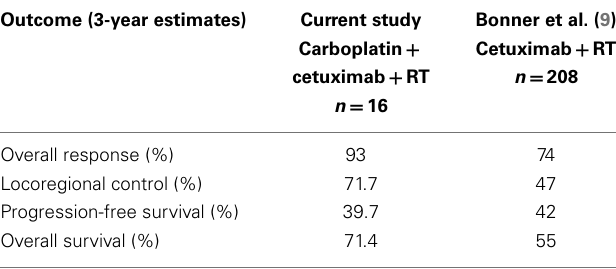
Table 5 | Comparison of outcomes